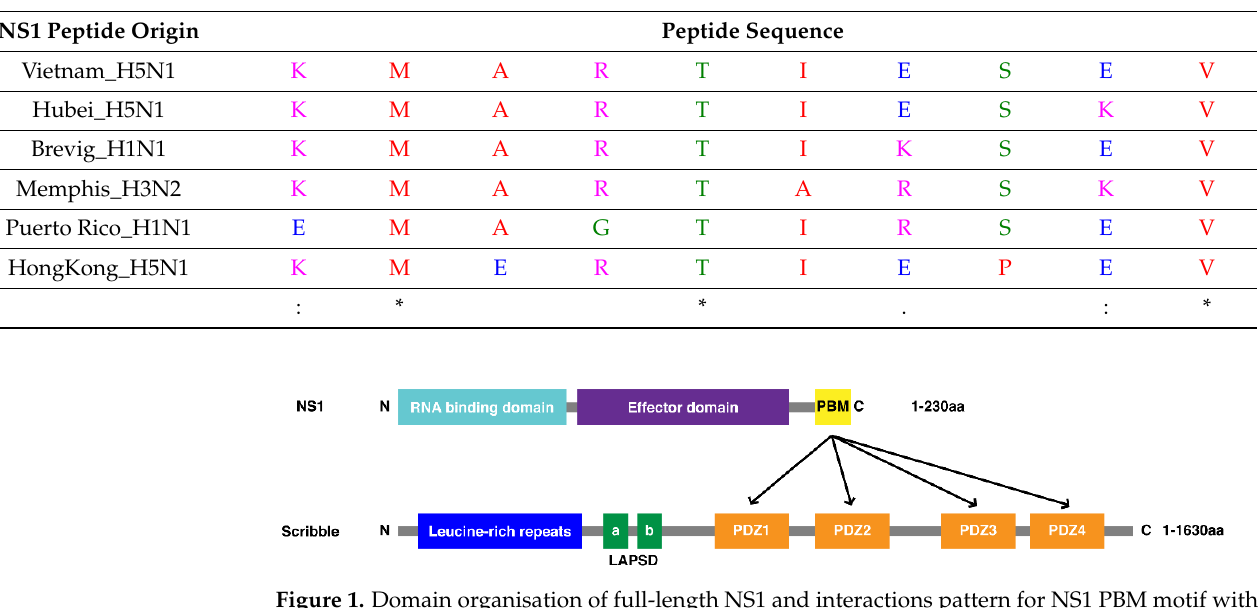
Figure 1. Domain organisation of full-length NS1 and interactions pattern for NS1 PBM motif with full-length SCRIB. Table 1. Overview of NS1 PBM motif peptides. (A) Sequence alignment of NS1 peptides and super- peptide created with Clustal Omega 1.2.4 multiple sequence alignment